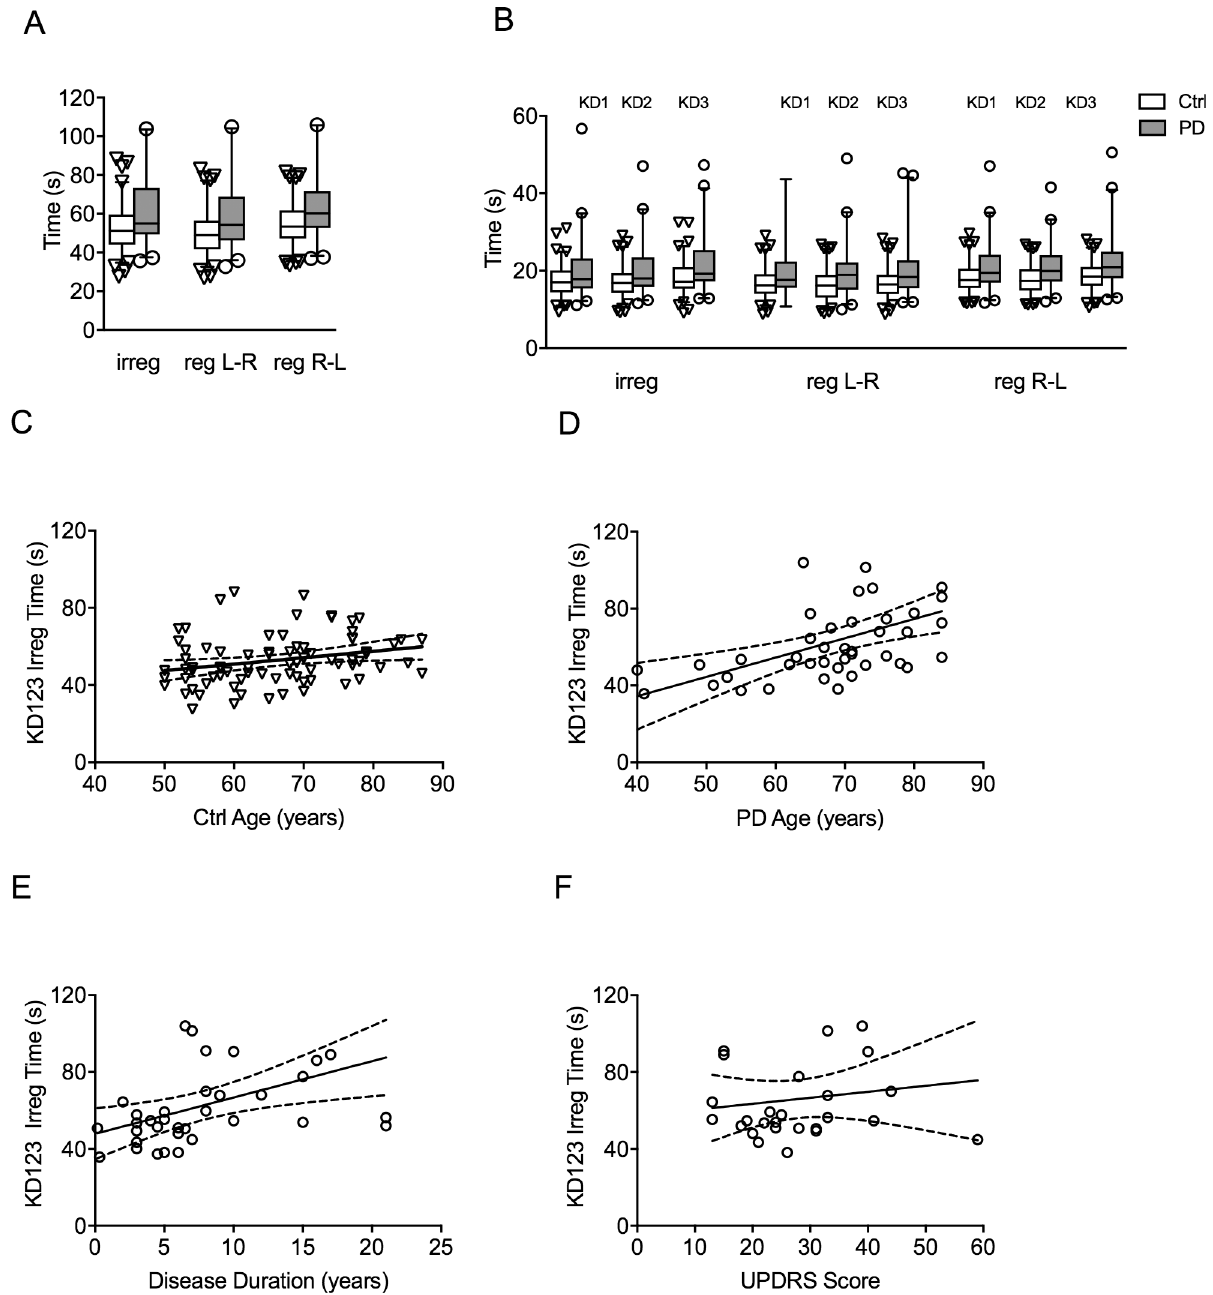
Fig 2. PD patients read significantly slower in all reading tasks. (A) Box-and -whisker plot of sum of KD1, KD2 and KD3 (KD123) reading times (3 pages or 120 numbers per task) for KD123 irreg, KD123 reg L-R, and KD123 reg R-L. (B) Box-and-whisker plot of individual KD reading times (1 page, 40 numbers per task). ( C ) Significant correlation between age and KD123 irreg reading time in the control group (R 2 = 0.06853 p = 0.0206). ( D ) Significant correlation between age and KD123 irreg reading times in PD (R 2 = 0.02389, p = 0.0010). ( E ) Significant correlation between disease duration and KD123 irreg reading time in PD group (R 2 = 0.1905 p = 0.0088). ( F ) No correlation between UPDRS score and KD123 irreg reading time (R 2 = 0.01811 p =